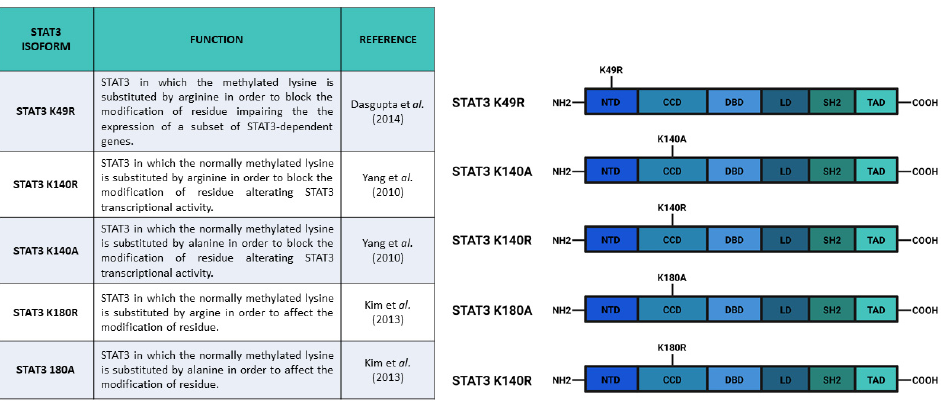
Figure 5. Main constructs used to investigate STAT3 methylations. Created with BioRender.com. Interestingly, methylation of STAT3 on K180 and K49 residues have an opposite ef- fect on the regulation of STAT3-dependent transcriptional activity as compared with K140 STAT3 di-methylation, which negatively regulates STAT3 dependent transcription. Yang et al. [88] identified that histone-lysine N-methyltransferase SET9 was responsible for di- methylation of K140, while lysine-specific demethylase 1 (LSD1) was able to demethylate MeSTAT3 K140. After IL-6 stimulation and consequent phosphorylation of STAT3 Y705 and S727, SET9 di-methylated K140. Yang and collaborators demonstrated that pSTAT3 S727 was needed for K140 di-methylation, hence, they supposed its involvement in a pos- sible SET9–STAT3 interaction. As previously reported, this methylation is a negative reg- ulator for the expression of a specific subset of STAT3 target genes. Indeed, Yang et al. identified three classes of genes that differentially responded to the absence of K140 meth- ylation. Some STAT3 target genes (such as SOCS3 , FGF21 , IRF8 , and IRF9 ) were upregu- lated in STAT3 K140R cells as compared with wild type cells, while other genes (such as HSF1 and CDCA1 ) were downregulated; conversely, another group of genes (such as CD14) did not show expression alterations. All in all, the evidence mentioned thus far has demonstrated that methylation is fun- damental for the regulation of STAT3 activity. MeSTAT3 K49, on the one hand, is induced by pSTAT3 Y705 and potentiates STAT3 transcriptional activity [82]; MeSTAT3 K180, on the other hand, induces pSTAT3 Y705 activating the pathway [83]; and MeSTAT3 K140 negatively regulates a subset of STAT3 target genes [79]. Since STAT3 has a prominent role in tumor growth and progression, the results described above about STAT3 methyl- ation must be considered in studies on STAT3 inhibitors as therapeutic treatments.